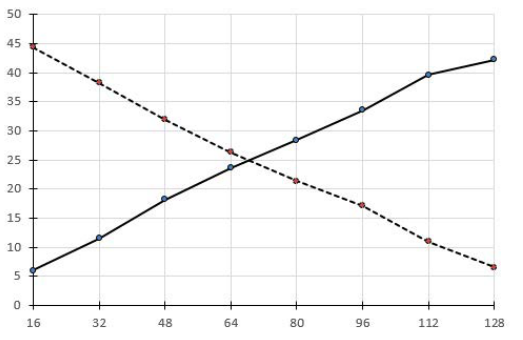
Figure 18. Throughput of private (solid line) and public (dashed line) cloud vs. maximum number of VMs in the private